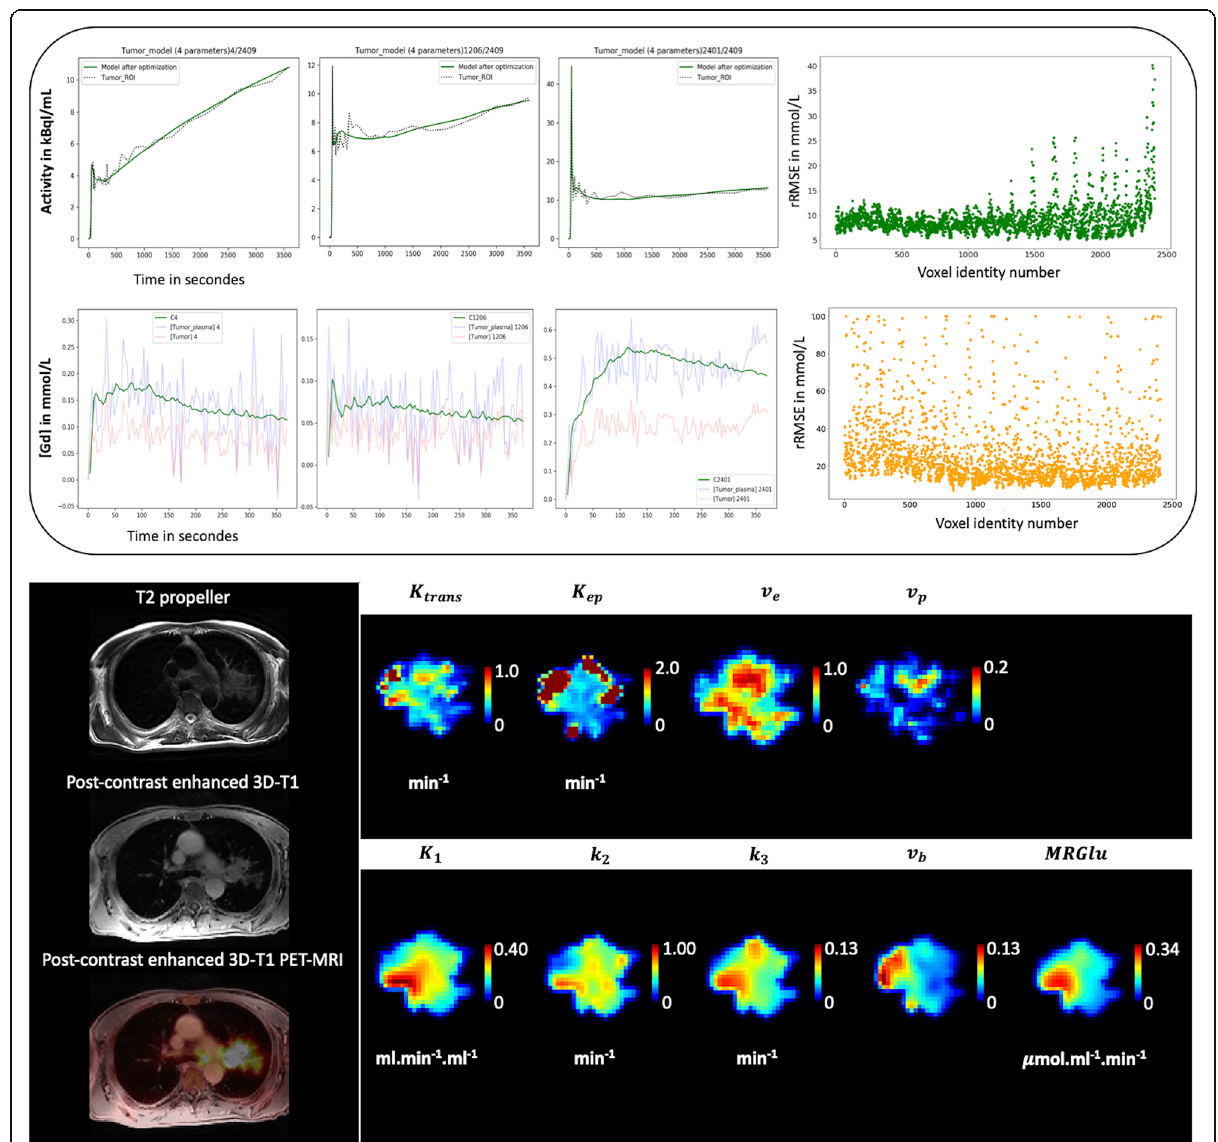
Fig. 3 Illustration of the PET and DCE kinetic estimated parameter maps (patient n°9). Top: voxel-wise fitting results are provided for three voxels of interest. The PET signal is expressed in kBq/mL and the DCE signal in mmol/L of Gd. For the latter, the blue curve corresponds to the measured [Gd] Plasma , whereas the red one corresponds to the measured [Gd] Blood before plasma conversion. The voxel-wise rRMSE (PET in green, DCE in orange) are also provided at the tumor level. Bottom: the related PET and DCE 3D parametric maps after data